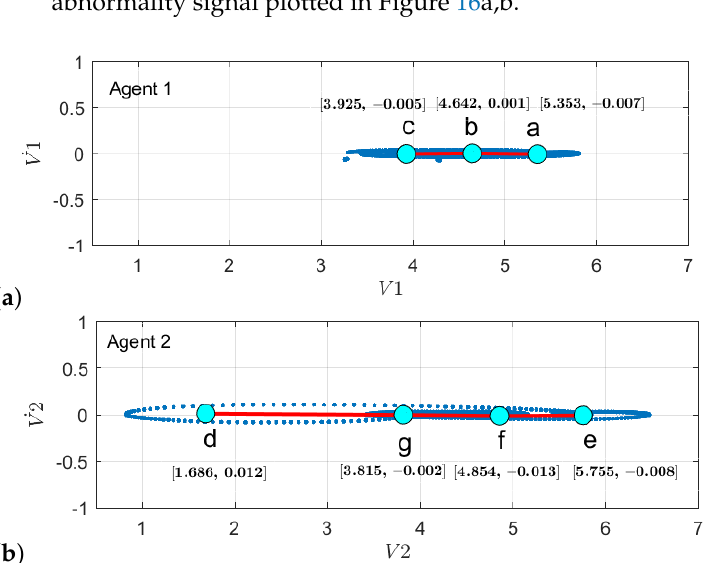
Figure 16. Clustering of GEs from incrementally learned model M 1 for ( a ) agent 1 and ( b ) agent 2